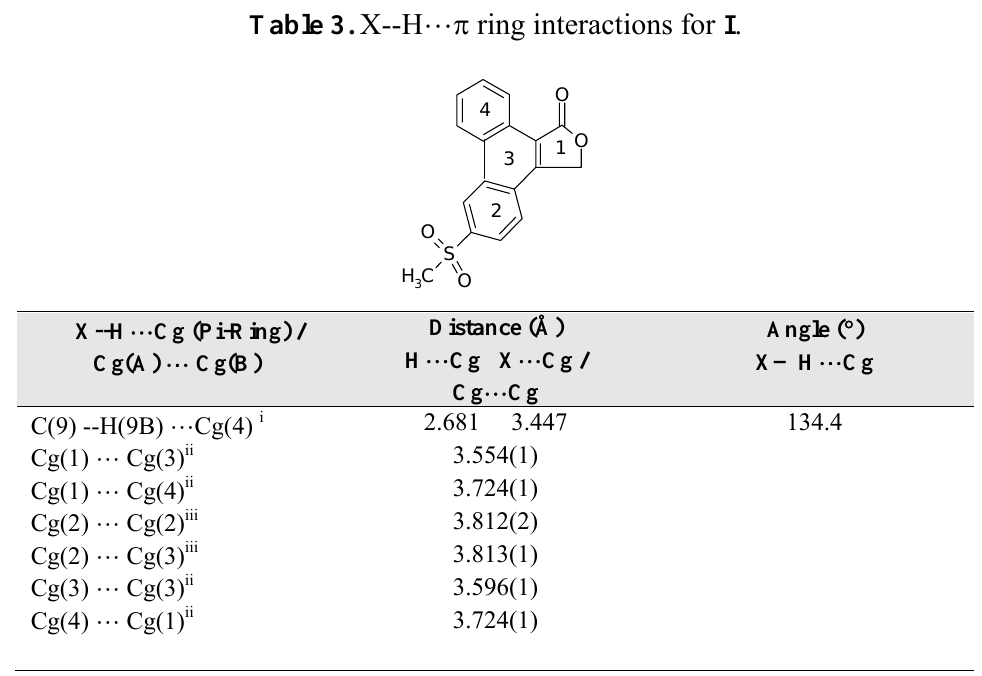
Table 3. X--H L π ring interactions for I .